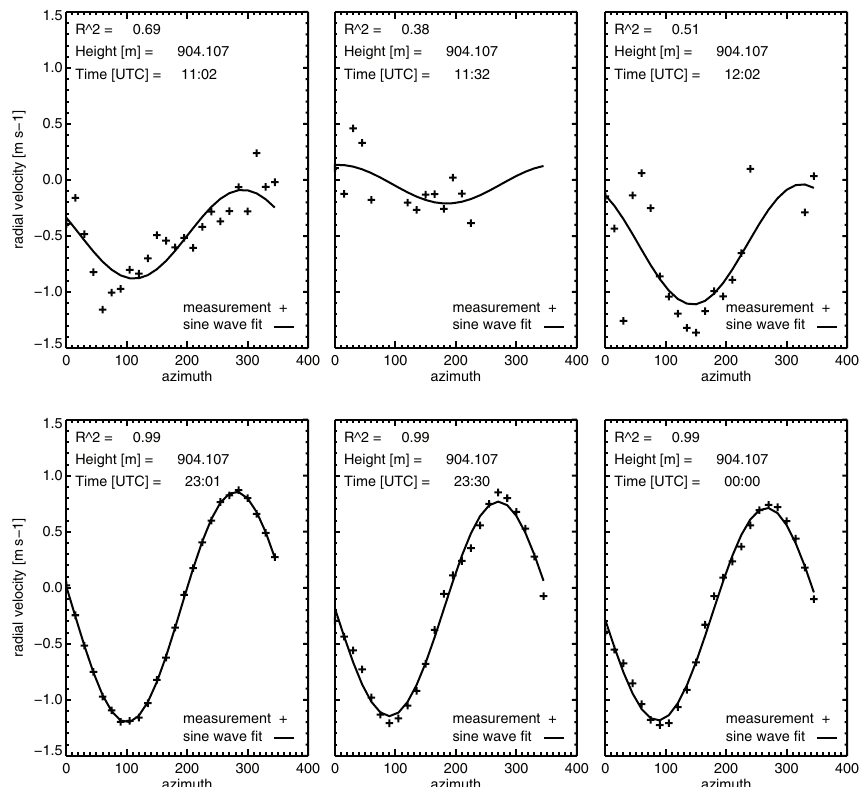
Figure 6. Examples of single sine wave fits into 30min averaged VAD scans used to reconstruct the 30min averaged wind profiles shown in Fig. 4 at 904 m height with the time stamps 11:02, 11:32 and 12:02 UTC (upper row) and the three time stamps 23:01, 23:30 and 00:00UTC (lower row). The measurements in the upper line were obtained during a well evolved CBL where horizontal homogeneous conditions were not met, which is also reflected in the low R 2 values. The measurements in the lower row were obtained during stable atmospheric conditions at night. Here, the high values for R 2 indicate that the assumption of a horizontally homogeneous wind field is better